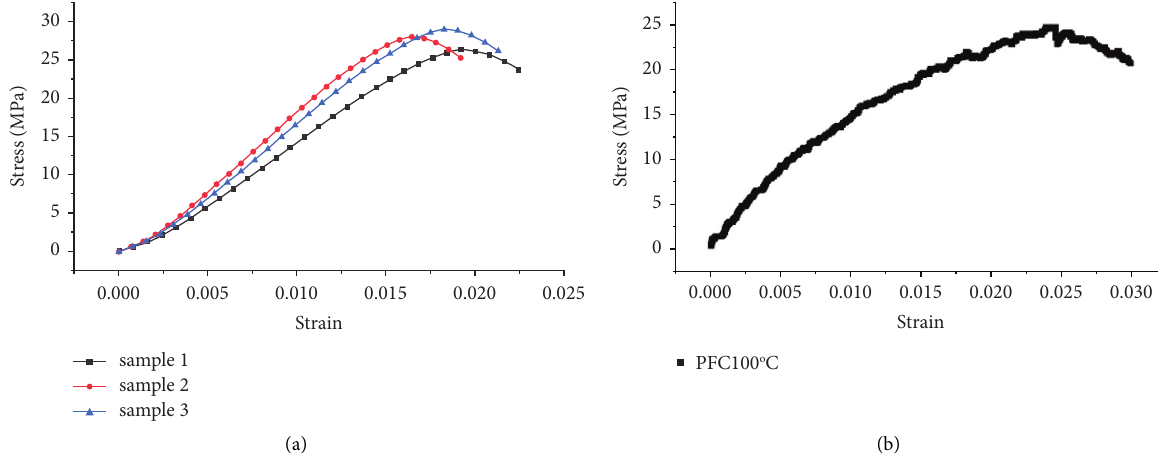
Figure 13: The concrete UCT stress-strain curves at 100 ° C: (a) the experiment results and (b) the PFC 2D result.